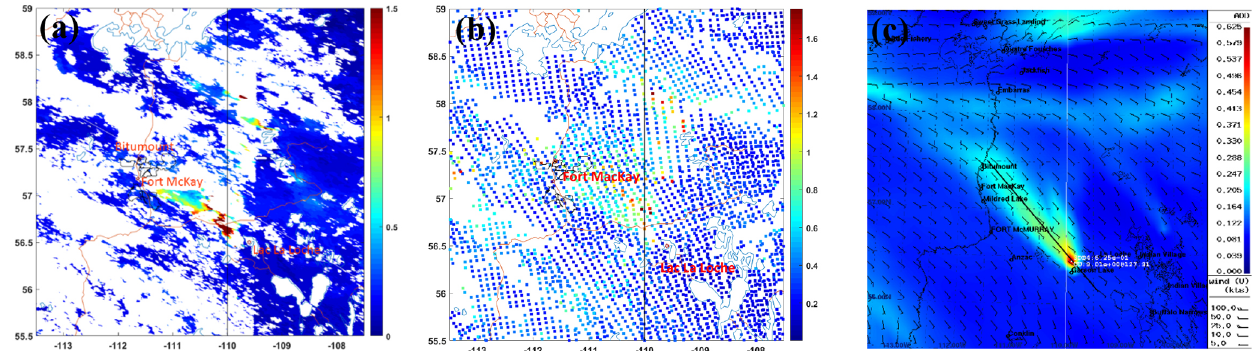
Figure 14. Lac La Loche forest fire, 25 June 2018 (a) MAIAC daily AOD at 550nm, (b) VIIRS daily AOD at 550nm and (c) GEM-MACH AOD at 580nm and horizontal wind bars at 23:00UTC. The color bar scale on VIIRS and GEM-MACH plots (b, c) show the true maximum values. The maximum AOD value in the MAIAC plot (maximum of 3) was scaled down to illustrate the fire plume. The cross sections in Figs. 15, 16 and 17 are plotted along the black line in panel (c)